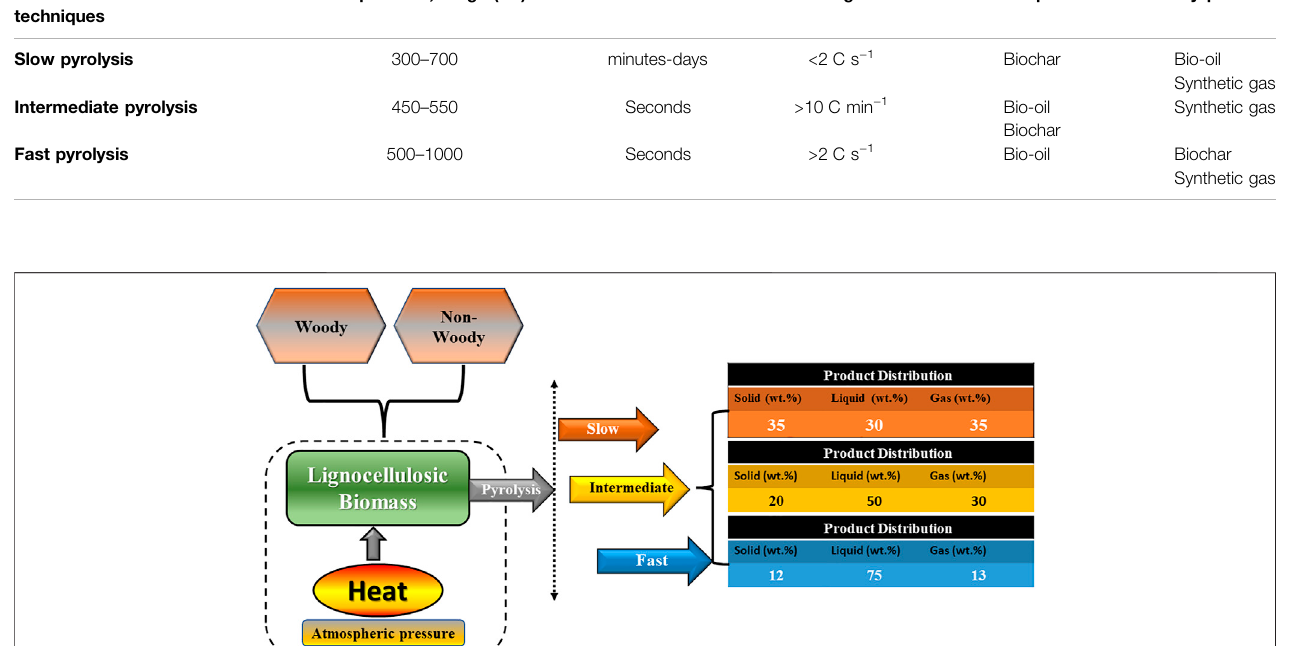
FIGURE 5 | Product distribution from different categories of pyrolysis (adapted and redrawn from Meyer et al., 2011; Qambrani et al., 2017).